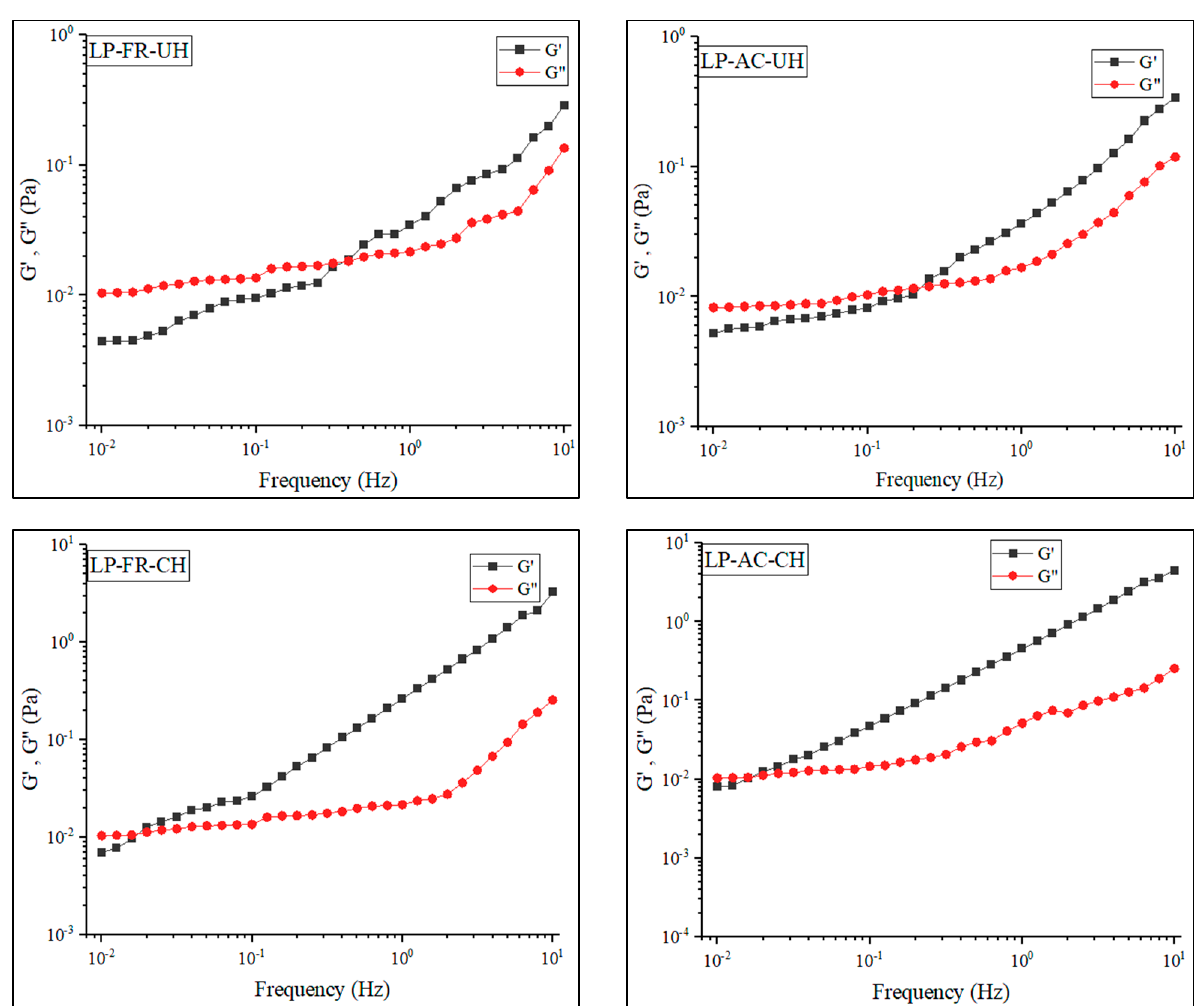
Figure 4. Frequency sweep of different nanoliposome samples at strain 10%.